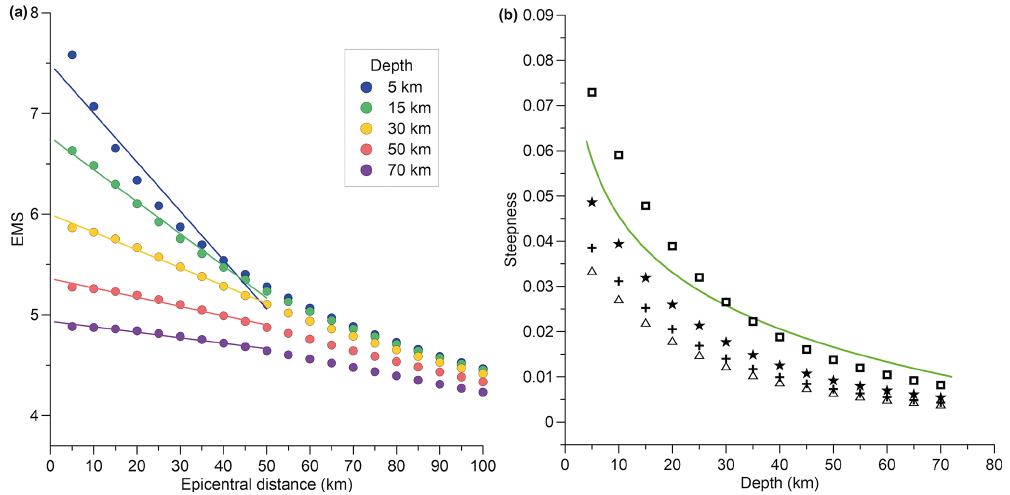
Figure 7. Attenuation curves and steepness simulated with different intensity or ground motion models for a M w 5.0 earthquake located at increasing depths. (a) Average intensity calculated using the IPE by Musson (2013) and the corresponding regression lines. (b) Attenuation steepness of intensities calculated using the IPE by Musson (2013) (stars), the IPE by Tosi et al. (2015) (crosses), and the GMPE by Cauzzi and Faccioli (2008); the PGAs predicted by this latter equation have been converted into MCS using the equations provided by Faenza and Michelini (2010) (squares) and by Masi et al. (2020) (triangles), respectively. All predictions are compared with the empirical Eq. (3), shown by the green line in panel (b)